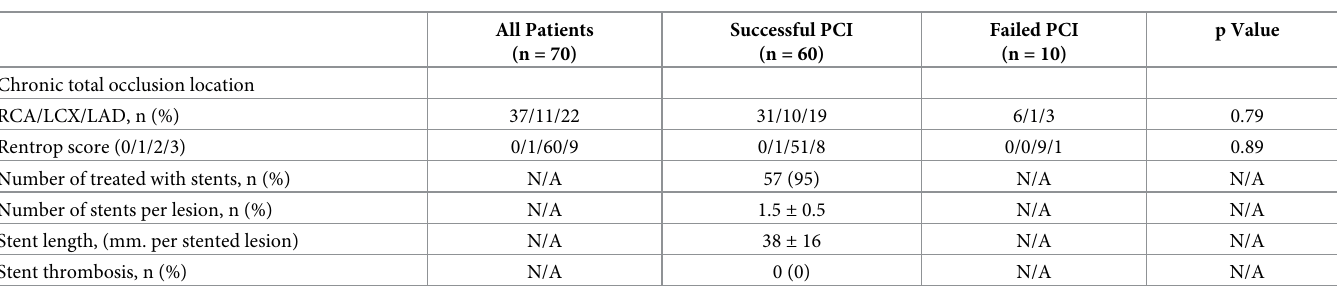
Table 2. Lesion characteristics.